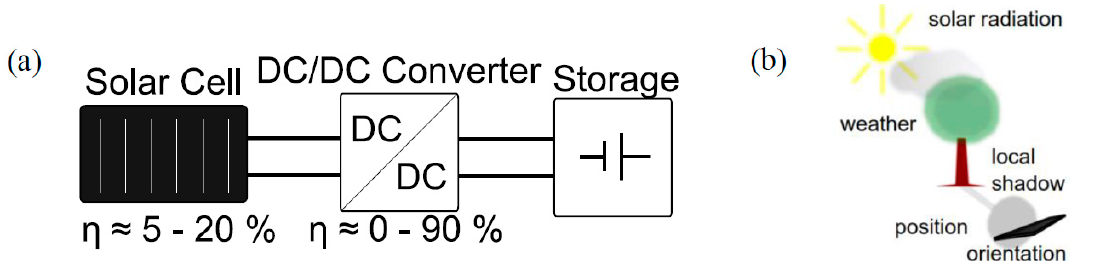
Figure 1. Influences on the harvestable energy of a sensor node: ( a ) Basic set up of a sensor node with a solar cell, DC-DC-Converter and an energy storage and their influence to the energy income. ( b ) Outdoor wireless sensor node and some general influences on the energy income.